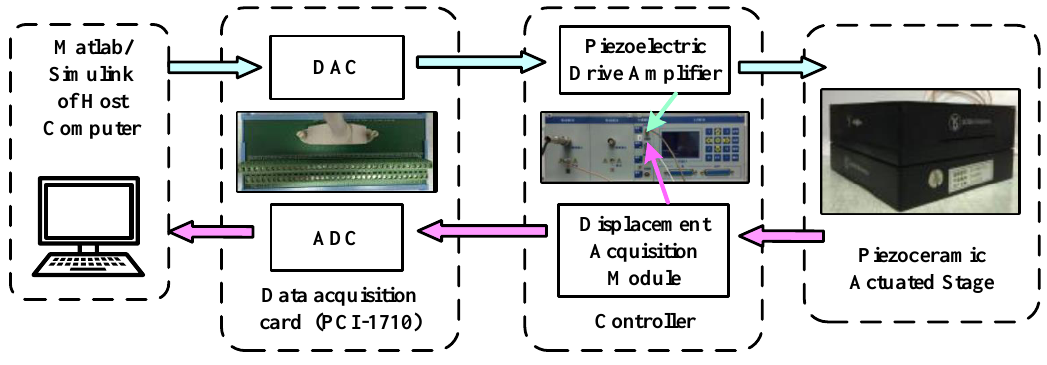
Figure 9. The experimental device structure of piezoceramic actuated stage control